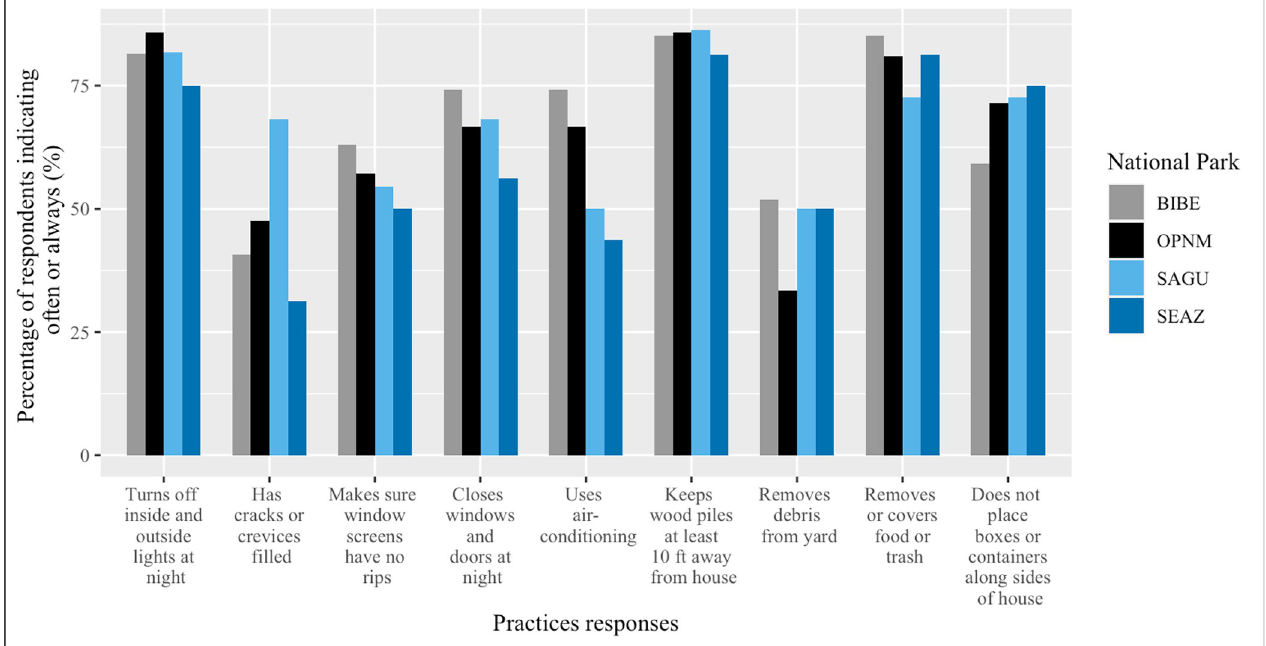
Fig 3. Proportion of respondents indicating often or always implementing practices by national park. Asterisks ( � ) indicates a significant difference between parks (p < 0.05).